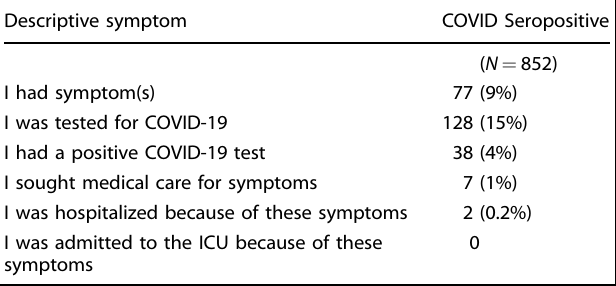
Table 2. Symptom descriptive in December and percent